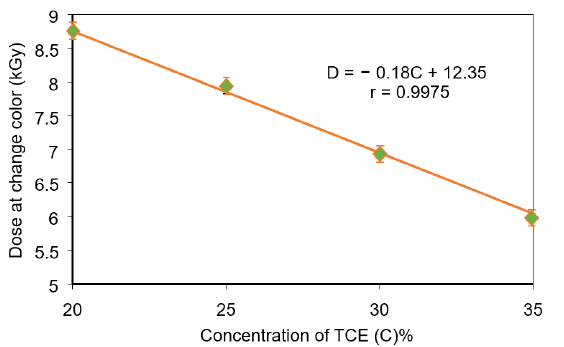
Figure 5. Useful critical doses as a function of TCE concentration for PVA-TCE-CR polymer films.